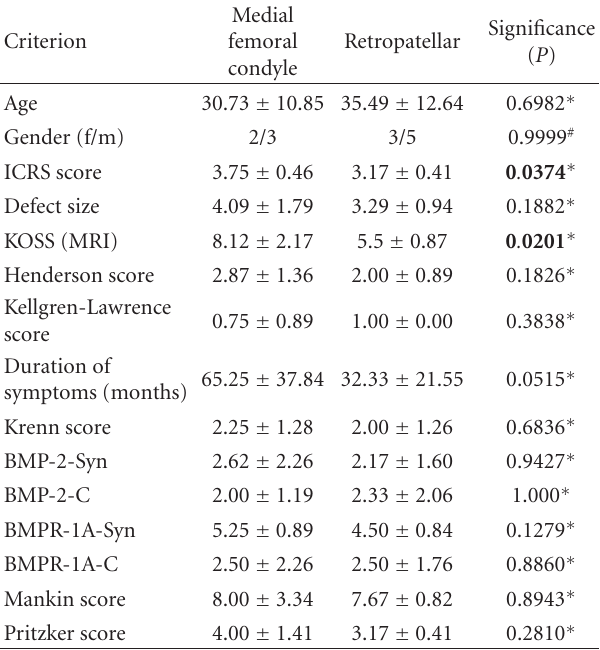
Table 4: Comparison between patients with di ff erent localizations of chondromalacia (retropatellar n = 6 or medial femoral condyle n =